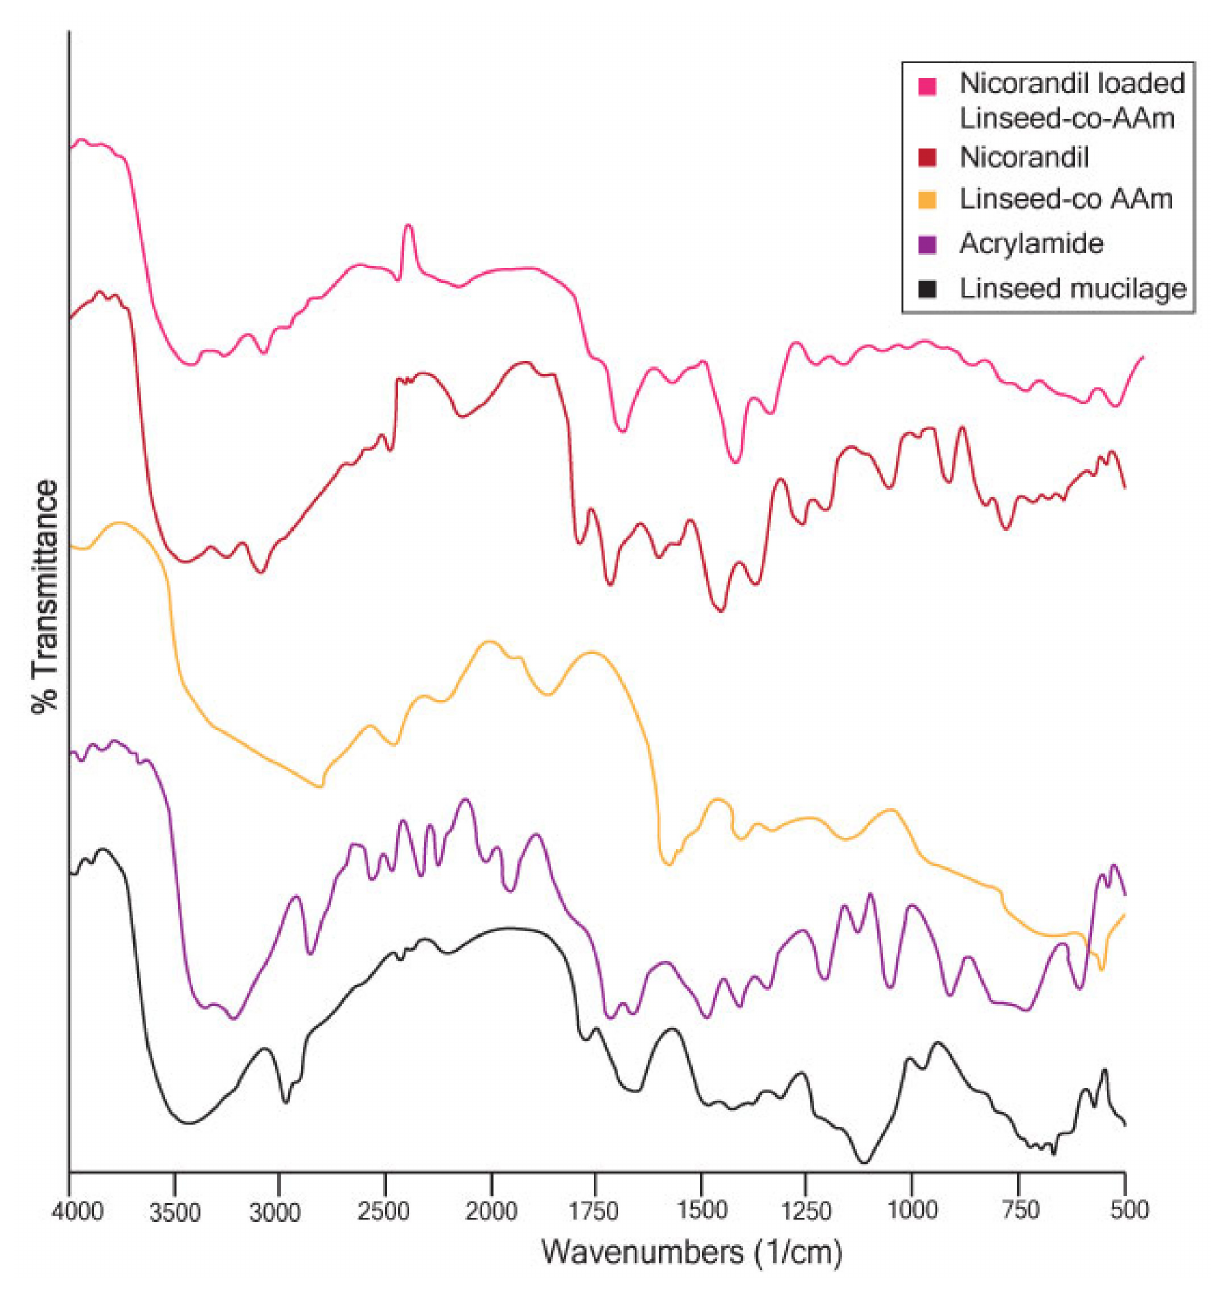
Figure 5. FTIR spectrum of linseed mucilage, AAM, linseed-co-AAM, Nicorandil and Nicorandil loaded Linseed-co-AAM